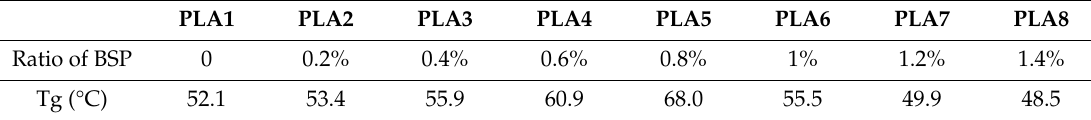
Table 1. Glass Transition Temperature of BSP / PLA Composite Films with Di ff erent Proportions.